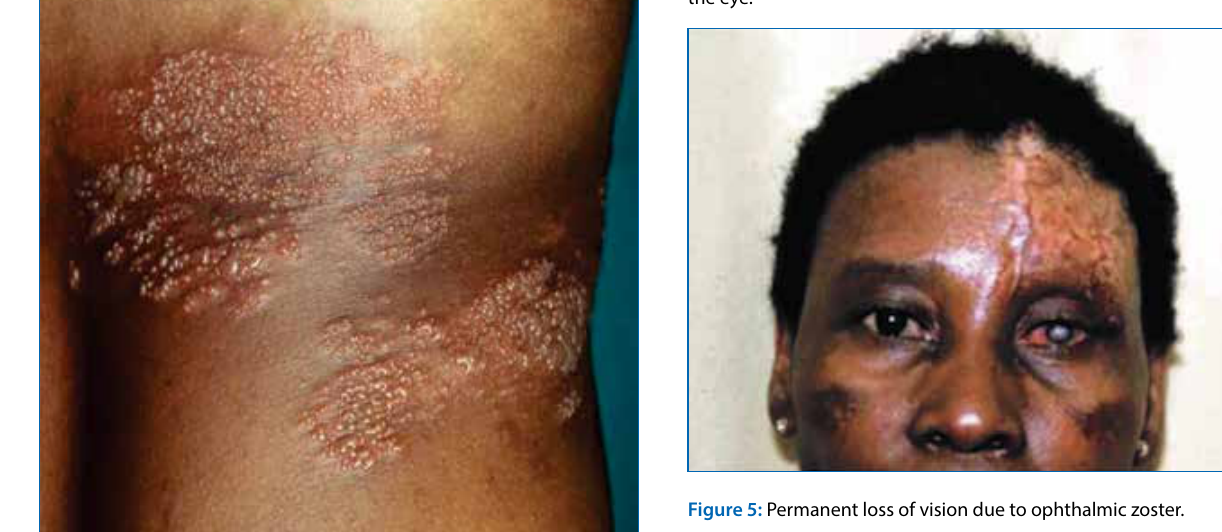
Figure 4: Secondary bacterial infection with a purulent discharge from the eye.